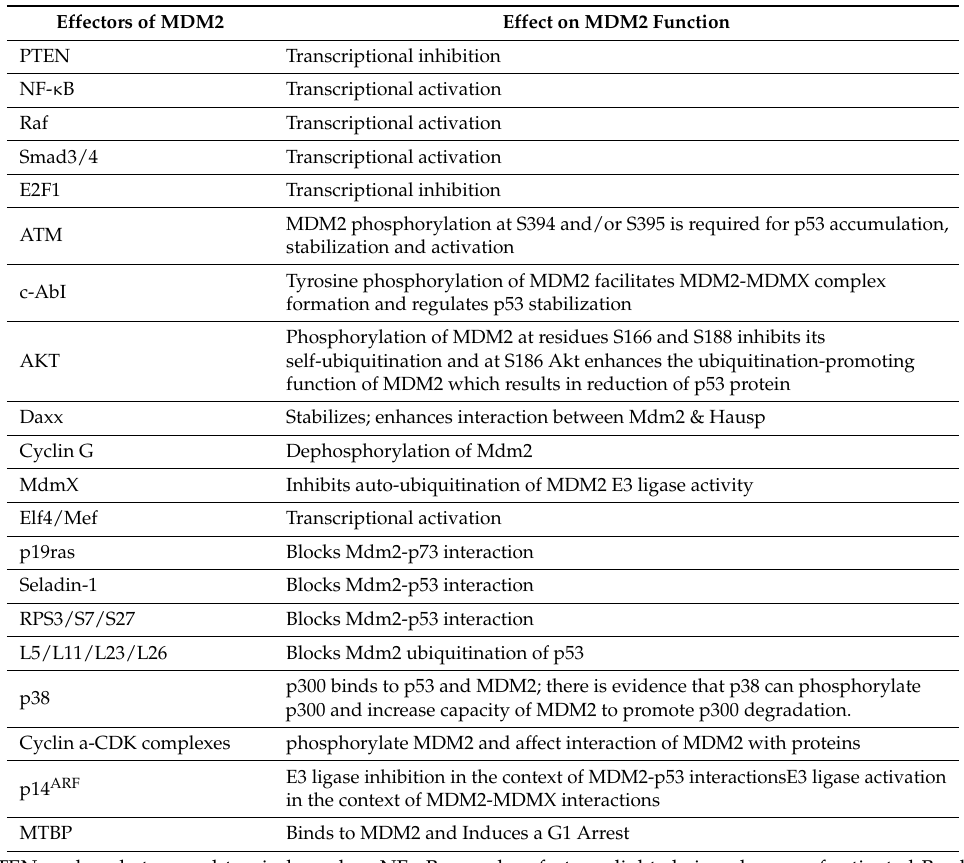
Table 2. MDM2 regulators and functional outcome [45,53,69,73–80].